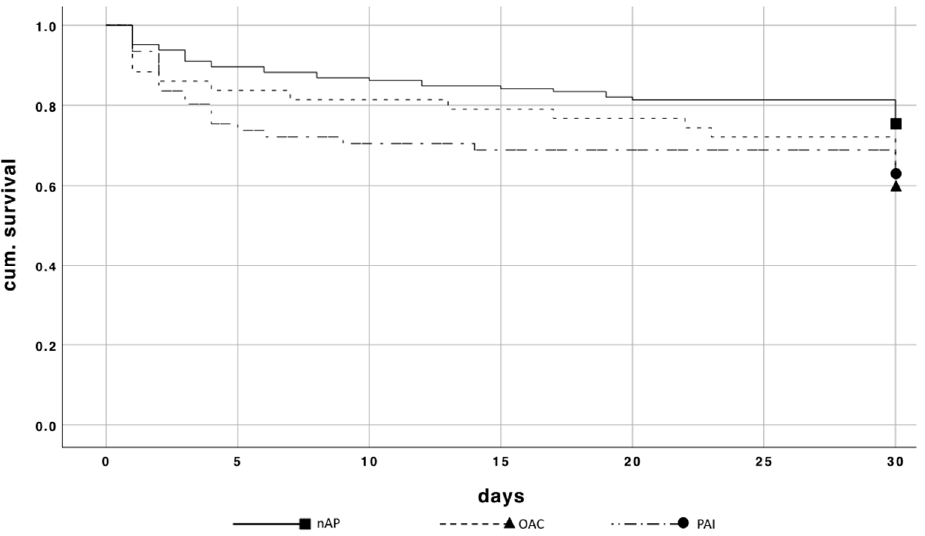
Figure 5. Kaplan–Meier curve of 30-day mortality comparing patients without OAC/PAI, with PAI, and with OAC.